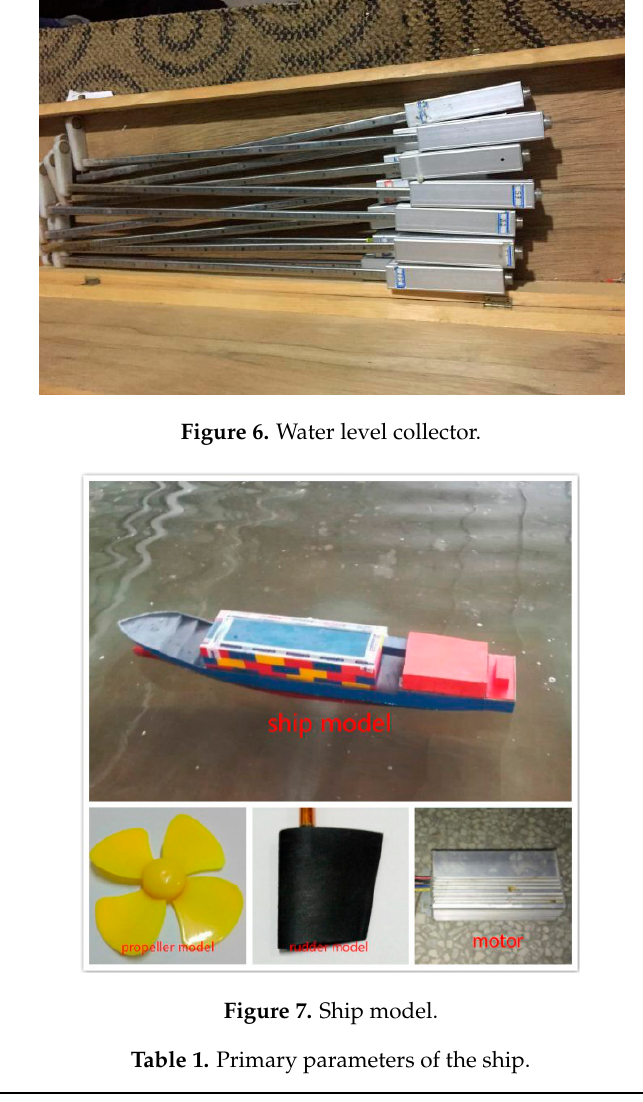
Figure 6. Water level collector.